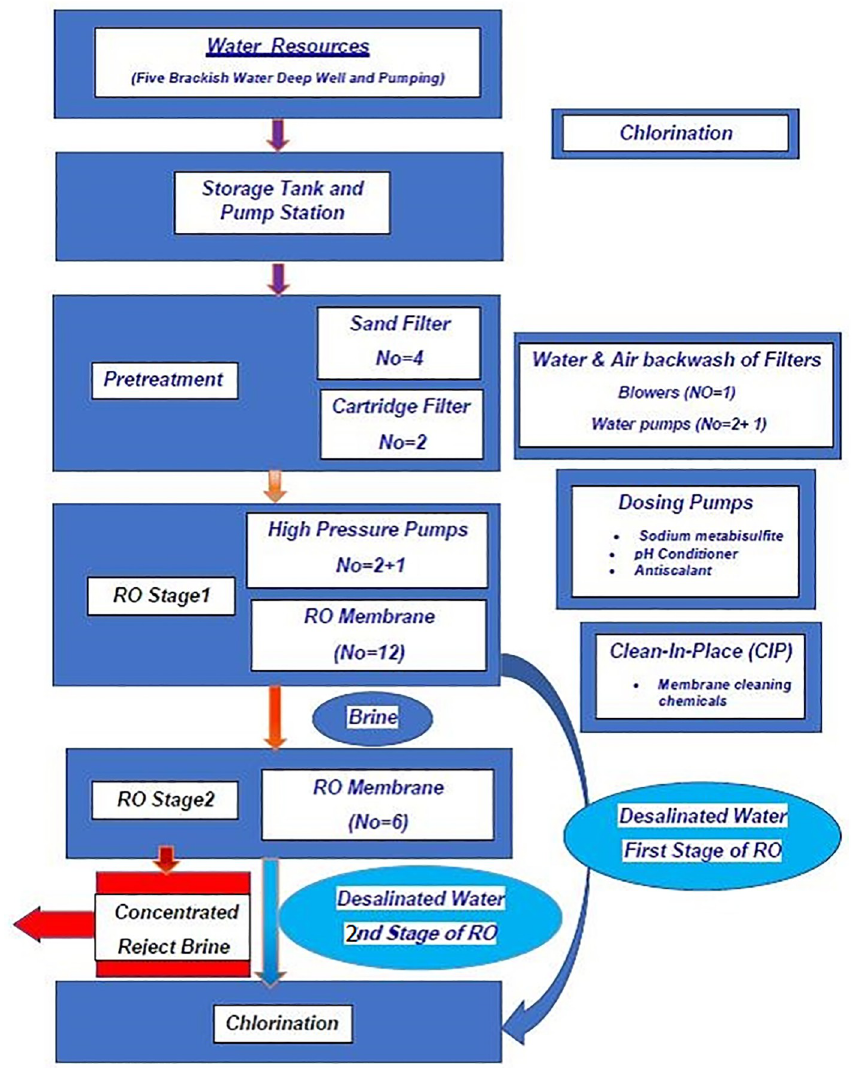
Fig 1. Pre-treatment and the 2 stage RO processes of the BWRO desalination plant (samples taken from the 1 st and 2 nd stage brine of the studied plant).